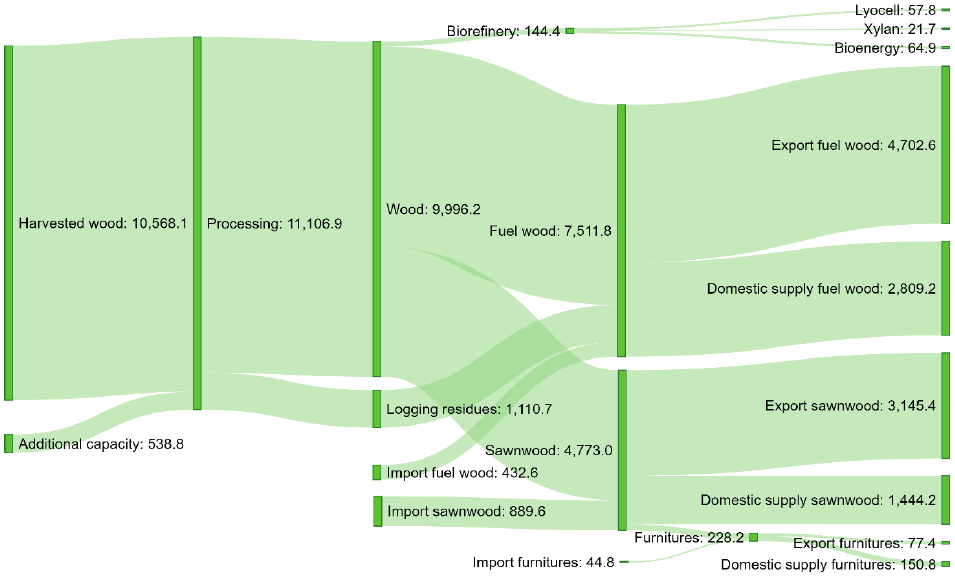
Fig. 8. Aggregated scenario for forestry sector bioresource flows in 2030, thousand